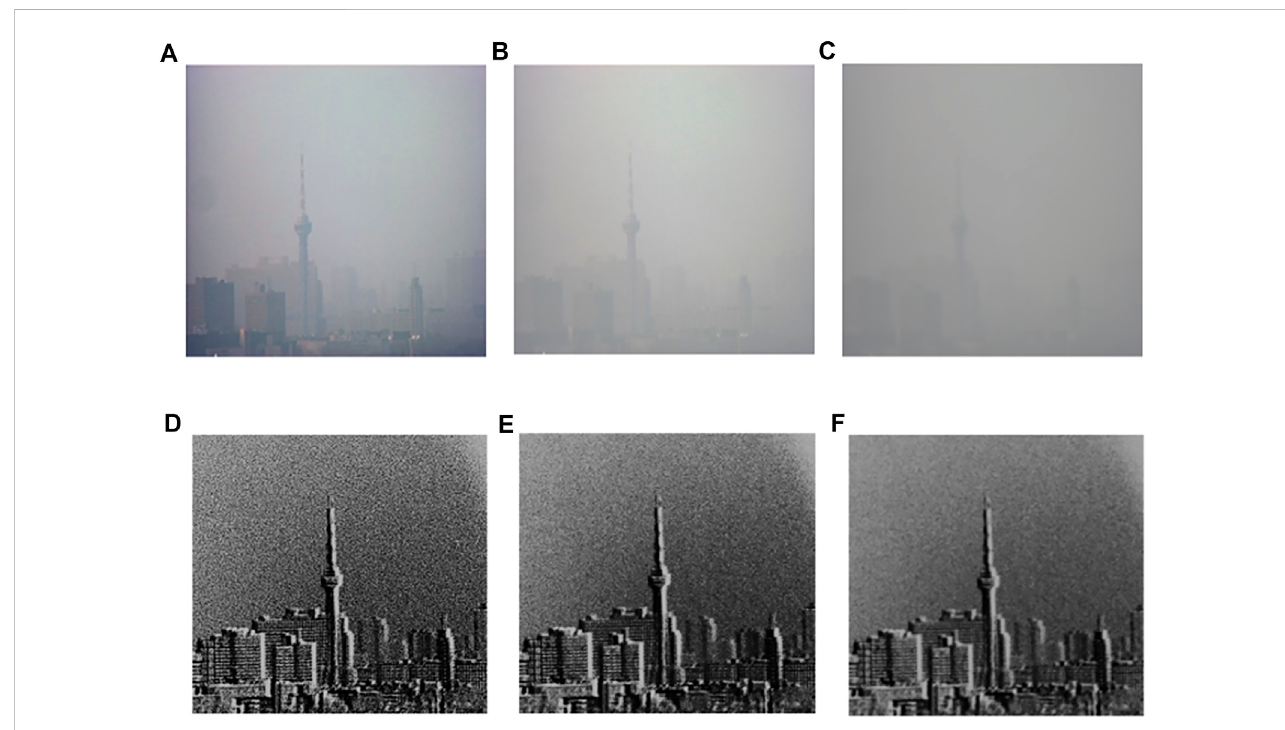
FIGURE 7 Intensity and Polarization images at different visibility levels. (A) Intensity image (visibility 5 km) (B) Intensity image (visibility 0.5 km) (C) Intensity image (0.05 km) (D) Polarization image (visibility 5 km) (E) Polarization image (visibility 0.5 km) (F) Polarization image (0.05